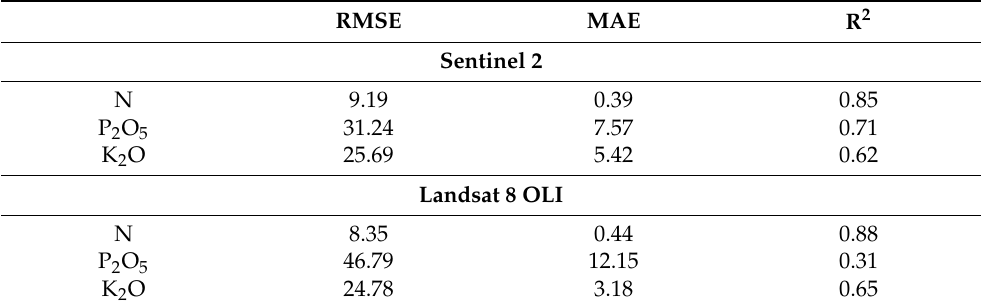
Table 4. Results of the evaluation of the accuracy of the best models (SVMr) based on a combination of remote sensing and soil